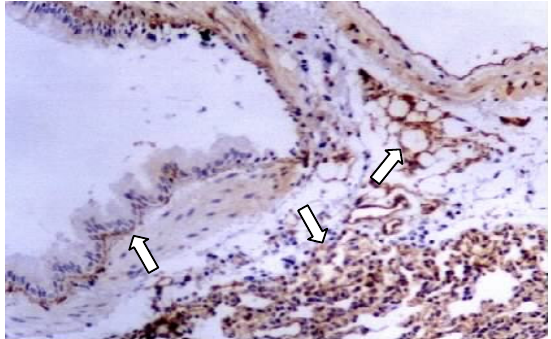
Figure 2. Localization of AQP1 in mice lung. AQP1 positive staining were found in capillaries, postcapillary venules, bronchiolar basal membrane and alveolar epithelial cells as arrows pointed(M group×100).